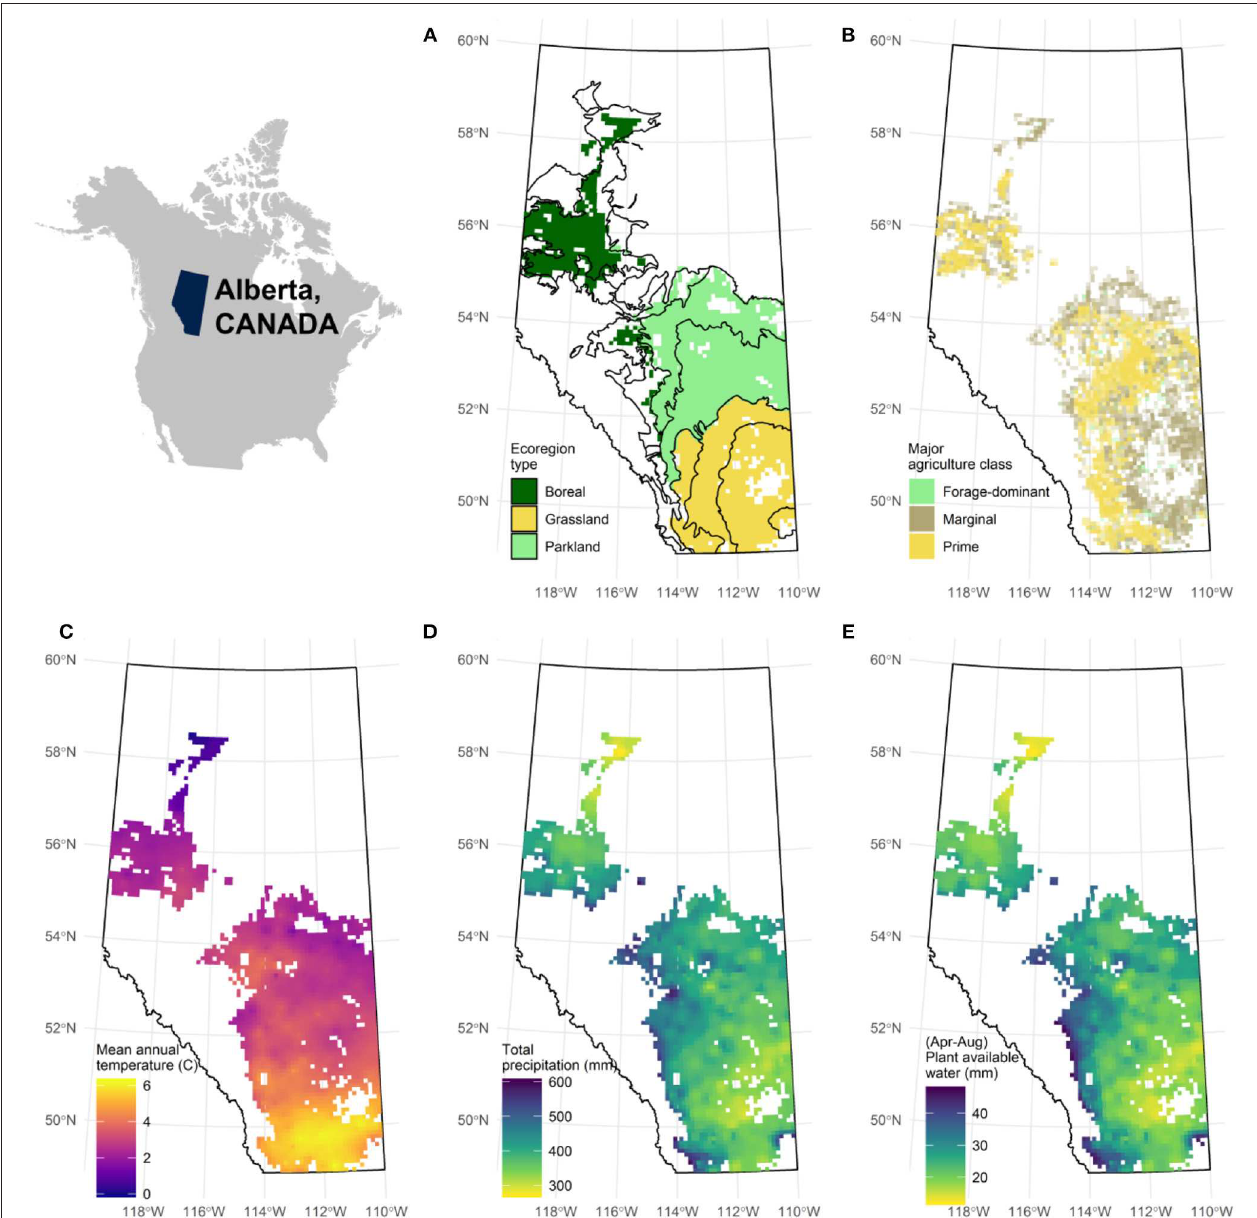
FIGURE 2 | Environmental gradients in Alberta, Canada used as covariates when modeling landscape complexity. A colored pixel on the map represents a survey township containing agricultural land ( N = 2,430). (A) Agricultural land intersects with 12 ecoregions (polygons) which can be broadly grouped according to their dominant non-crop vegetation; (B) Prime and marginal agricultural lands as determined by the limitations associated with cultivation; (C) Mean annual temperature (9 years means; 2009–2017); (D) Total precipitation (9 years means; 2009–2017); (E) Plant available water in the top 120cm of soil found as a daily mean between April and August (9 years means;